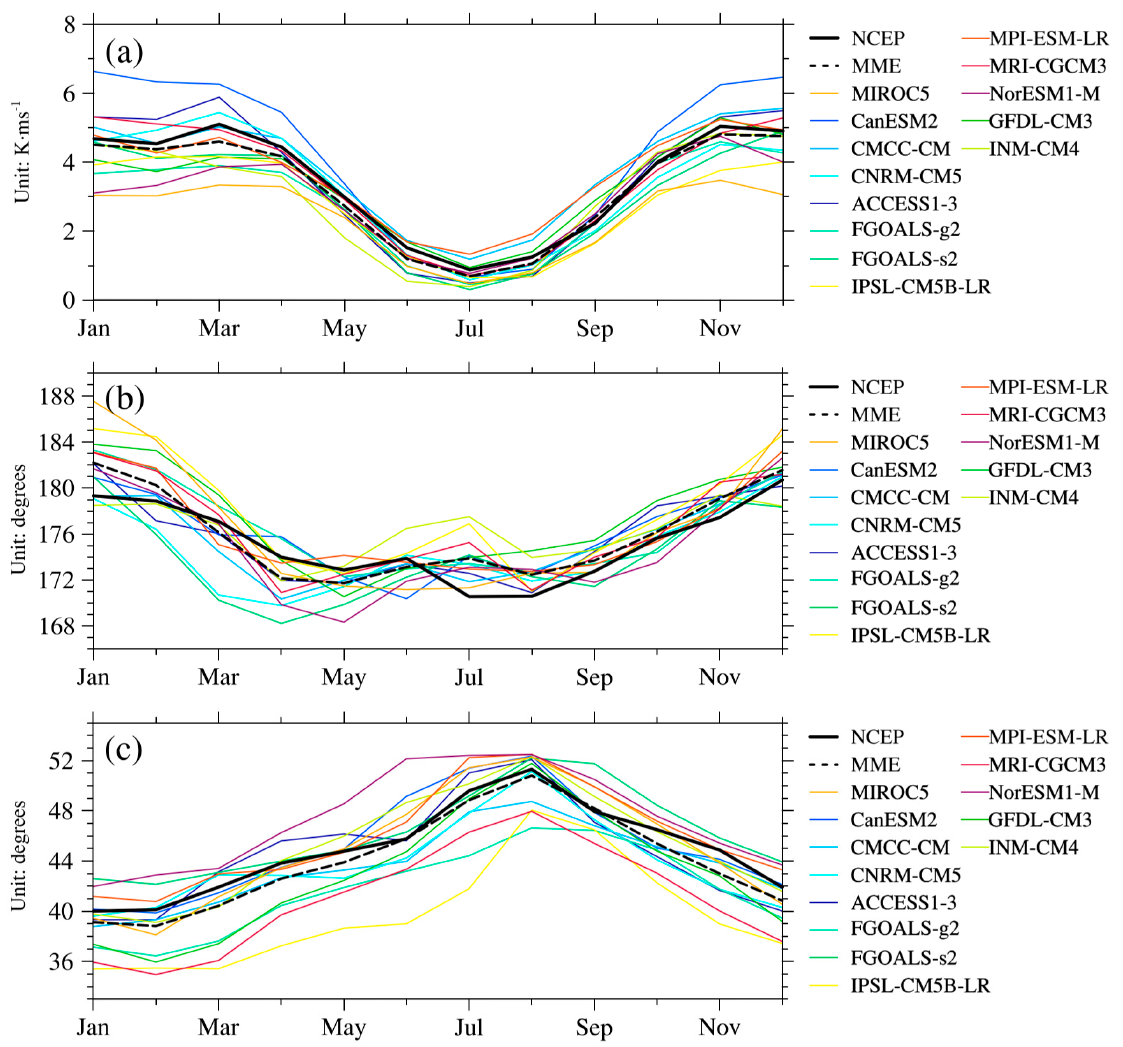
Figure 6. Climatological monthly variation of ( a ) strength index ( b ) longitude index and ( c ) latitude index.